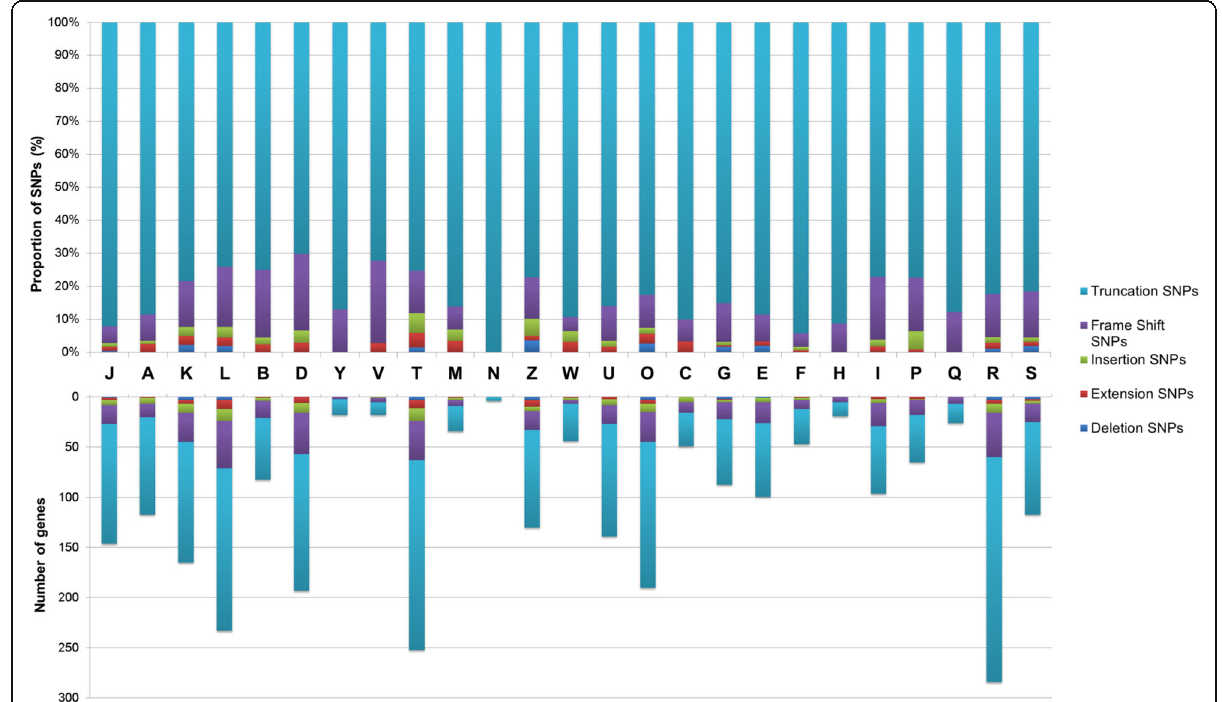
Fig. 6 Relative abundance of SNPs within genes assigned to KOG functional